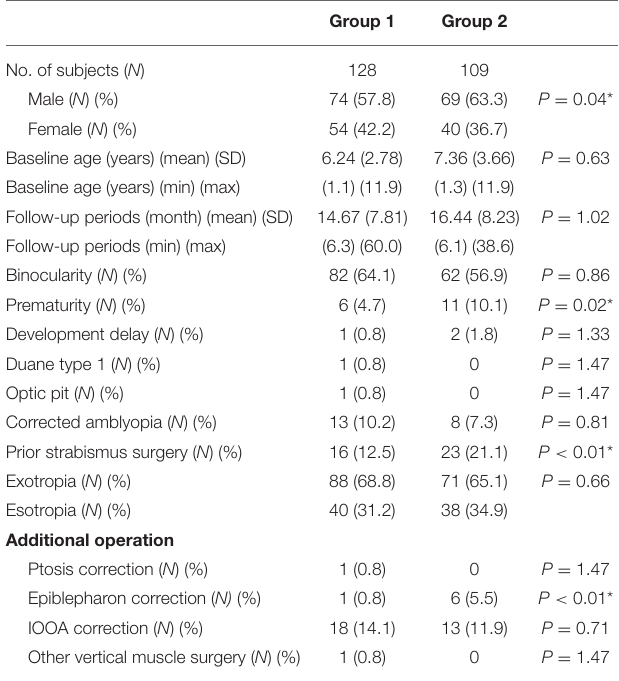
TABLE 1 | Demographic characteristics of children in the